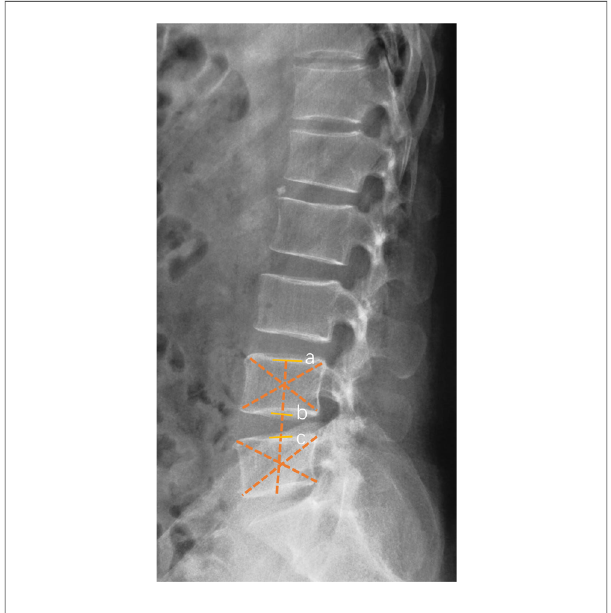
FIGURE 1 Schematic diagram of intervertebral disc height index (DHI) measurement. DHI was the ratio of intervertebral disc height (bc) to upper vertebral body height